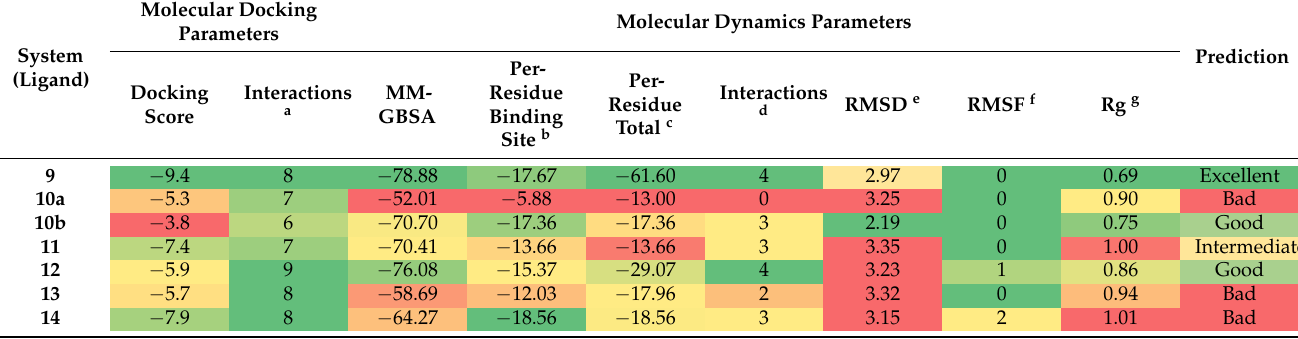
Table 8. Analysis of the seven parameters considered and the subsequent binding prediction. The six tested complexes related to the test set compounds 9 – 14 are ranked based on the experimental K D . Good values are in green, bad values are in red, and average values are in